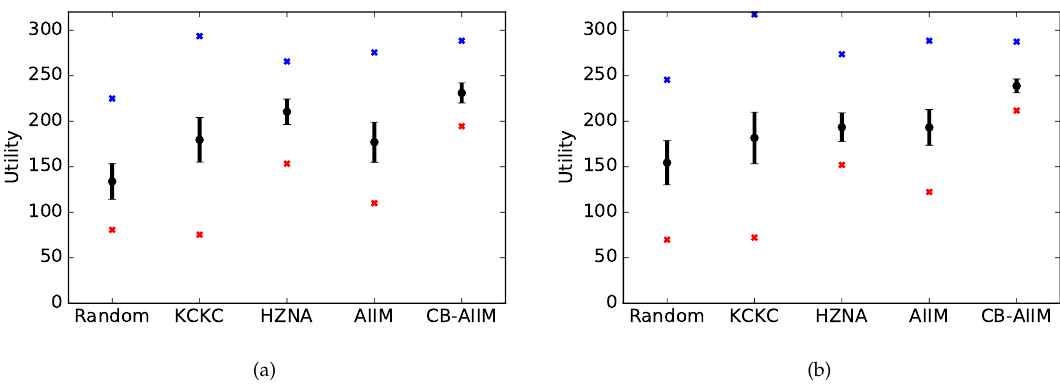
Figure 8. ( a , b ) Results for two different settings with high classroom occupancy (36 classrooms under use).